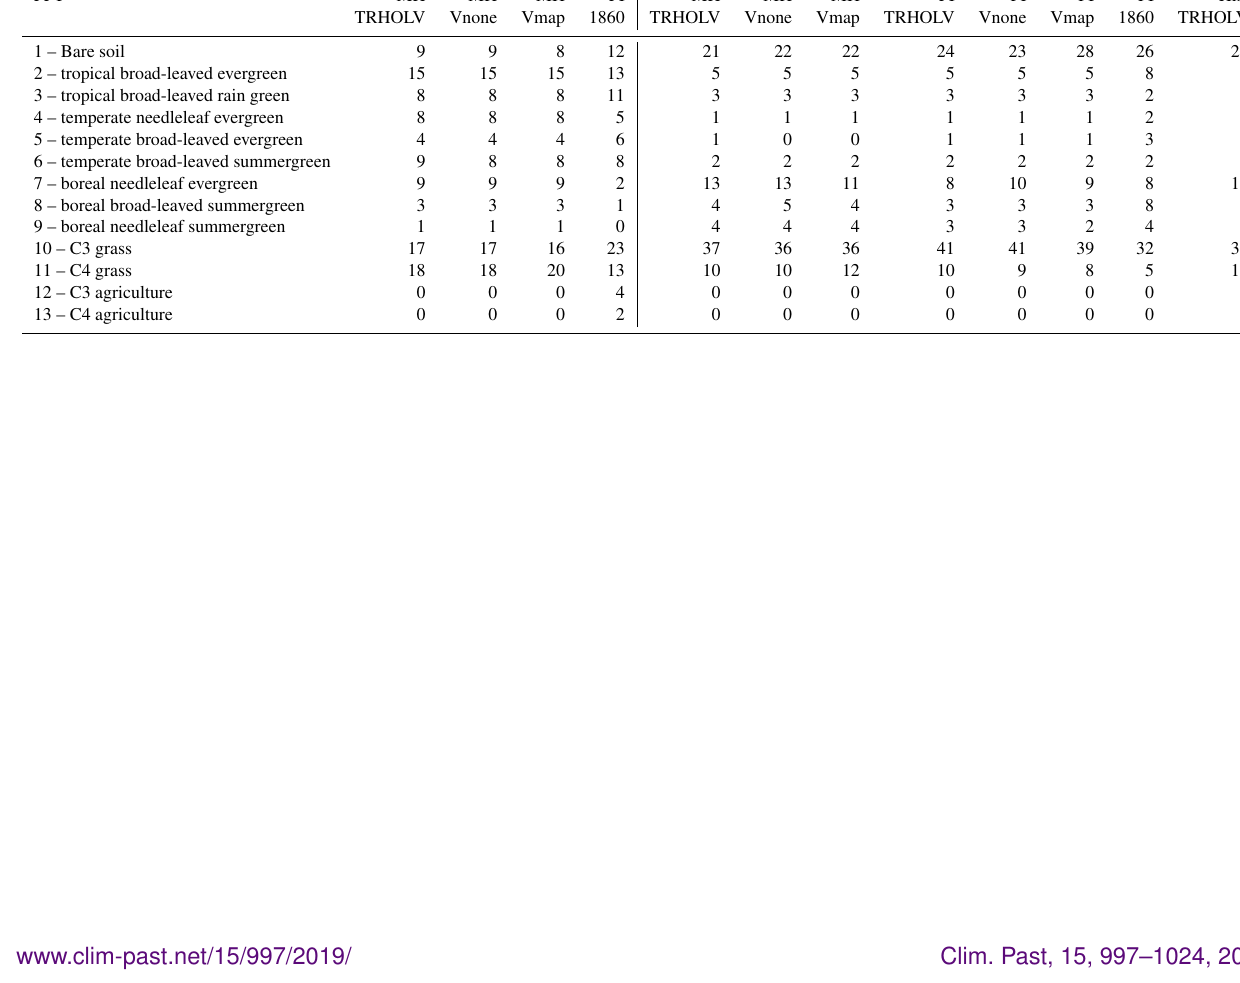
Table A1. Distribution of ORCHIDEE 13 PFTs (%) in different simulations and the PI 1860CE map used as boundary conditions when vegetation is prescribed from preindustrial observations. If the PI 1860CE fraction of land use in a grid box is larger than 0.01, then the grid box is considered as taken up with land use. The percentage is computed for each region separately, each region having its own total area. The error bars are about 0.5, which is accounted for in the table by neglecting decimals in the estimates. Regions with land use Regions without land use